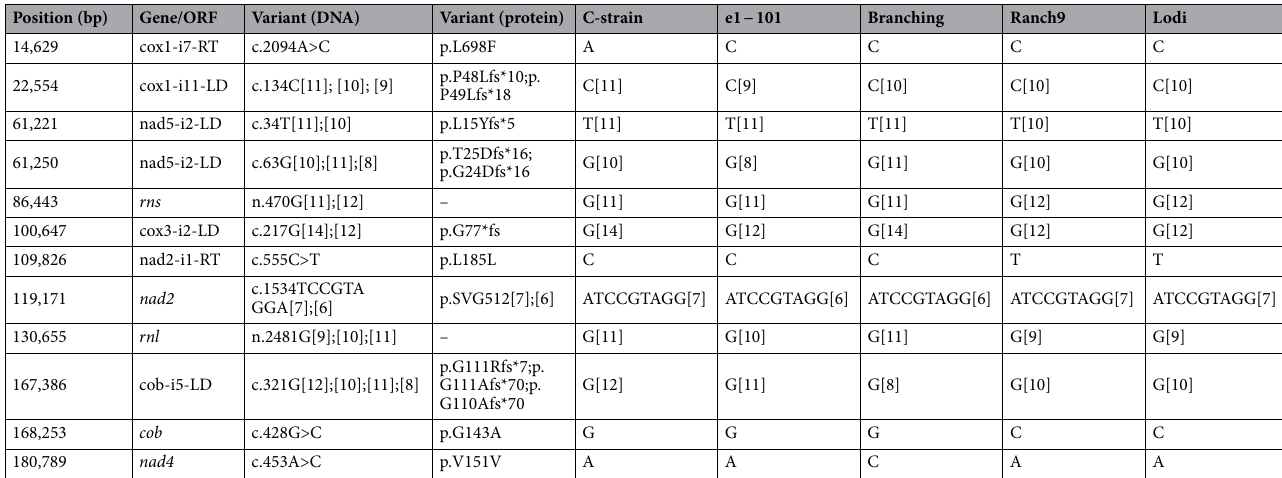
Table 3. Polymorphic sites within functional regions of the mitochondrial genome of Erysiphe necator. For each polymorphic site, its position in the genome is shown followed by the gene or intronic ORF affected by the polymorphism. The alleles for the respective isolates are shown. Variants at the DNA and protein levels are described according to the Human Genome Variation Society (HGVS) recommendations. Intronic ORFs encoding LAGLIDADG or reverse transcriptase domains are indicated with LD and RT, respectively.